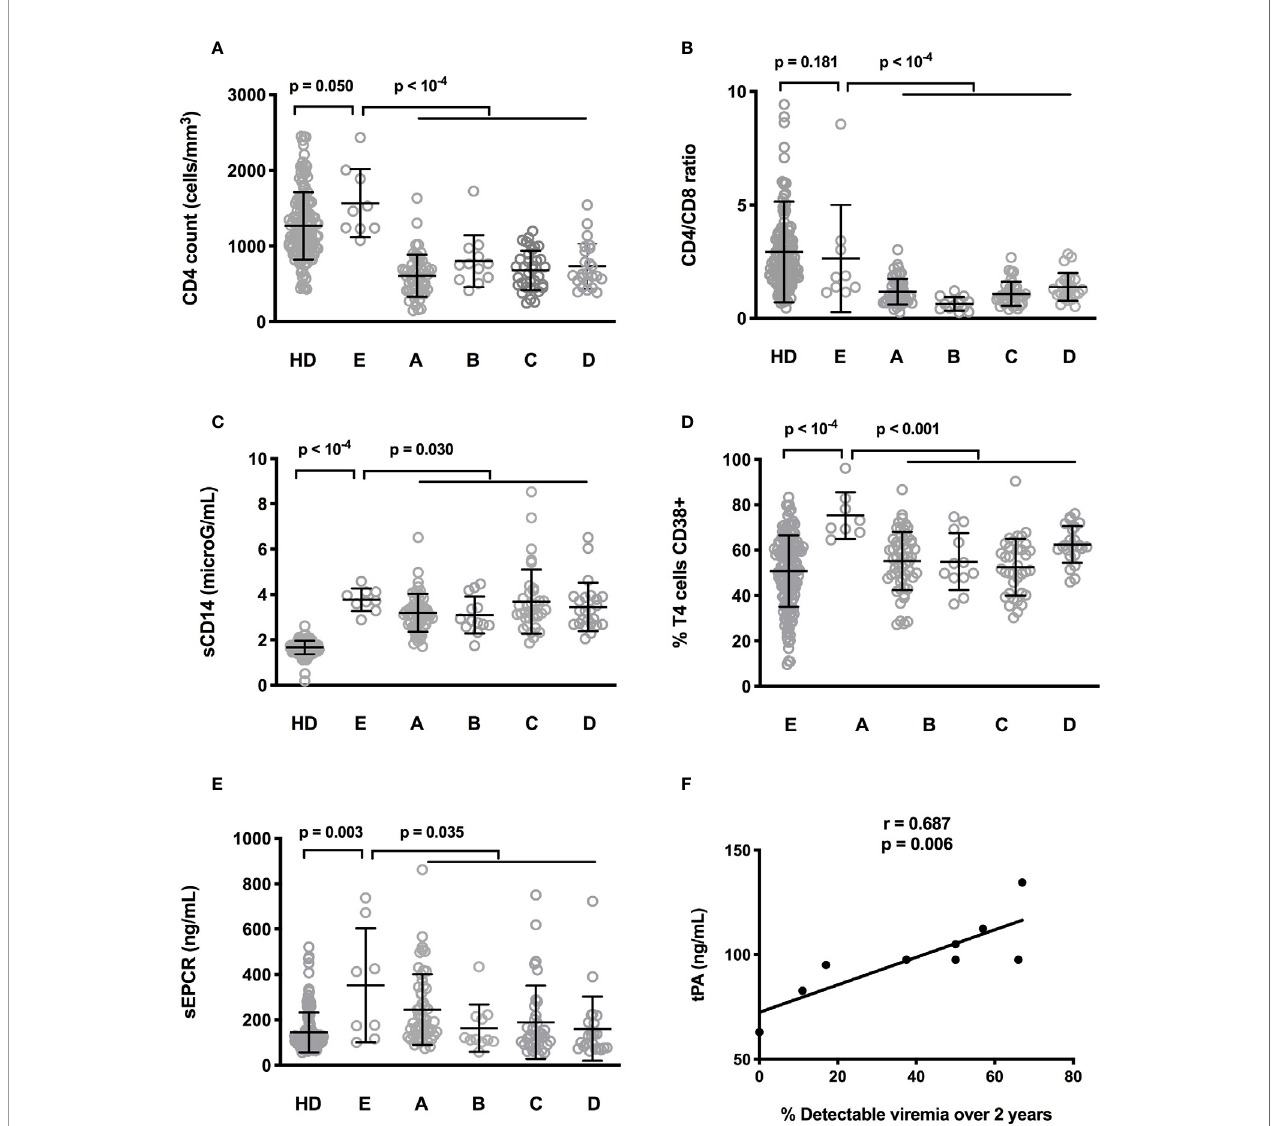
FIGURE 4 | Differences in CD4 count (A) , CD4:CD8 ratio (B) , sCD14 (C) , frequency of CD4+ T cells expressing CD38 (D) , and sEPCR (E) between healthy donors (HD) and people living with HIV-1 with the fi ve IA pro fi les. Statistical analyses were performed using a Mann-Whitney test. Correlation between low-level viremia over the two last years and tPA in Pro fi le E participants. Statistical analysis was performed using Spearman correlation (F)